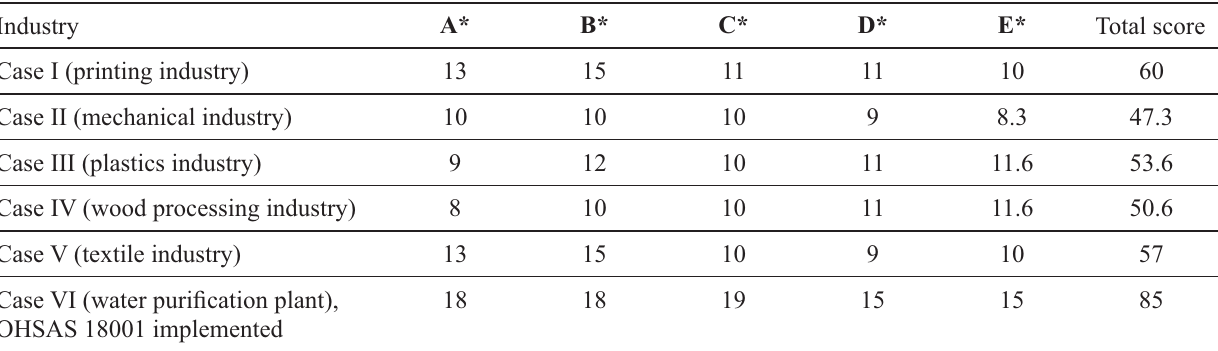
Table 3B. Results of auditing of safety system in Estonian enterprises